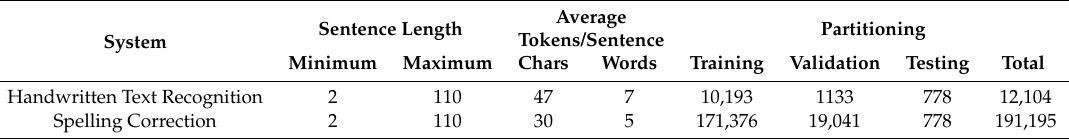
Table 3. Data distribution from RIMES (Reconnaissance et Indexation de données Manuscrites et de fac similÉS) database.